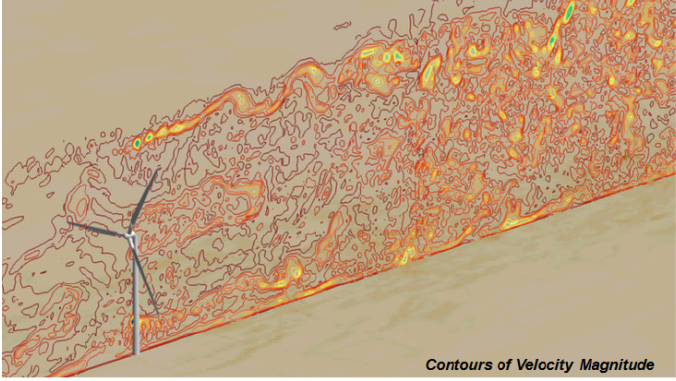
Figure 6. Instantaneous contours of velocity magnitude (NREL 5-MW Turbine 1, V Wind = 8